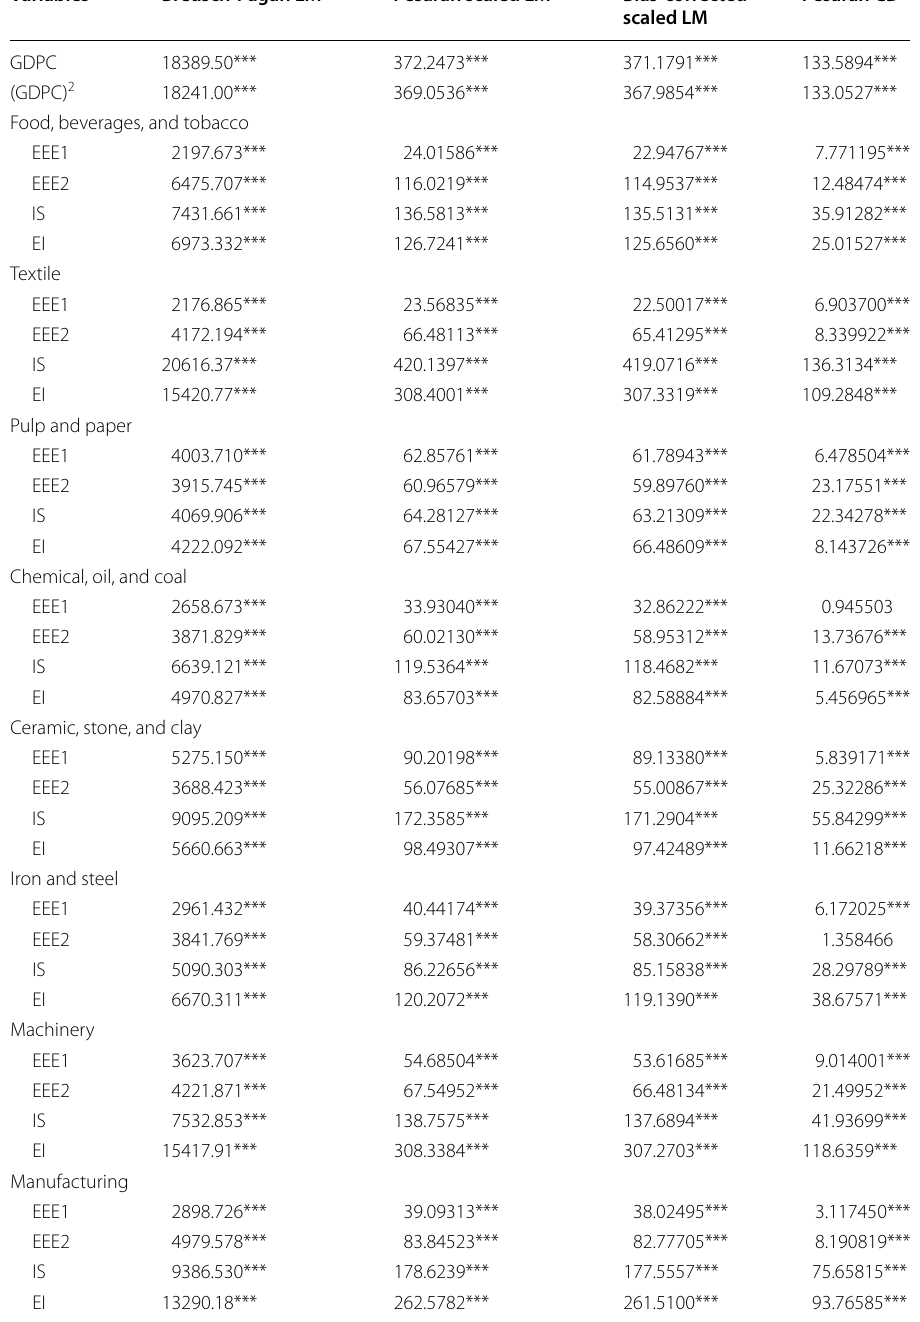
Table 4 Cross-section dependence (CD)